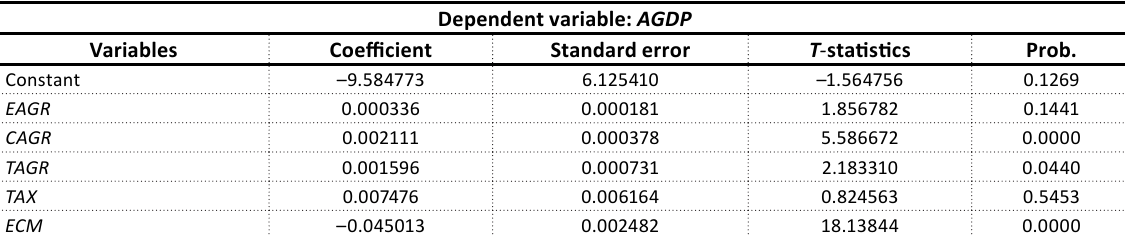
Table 2. Presentation of short-run dynamics